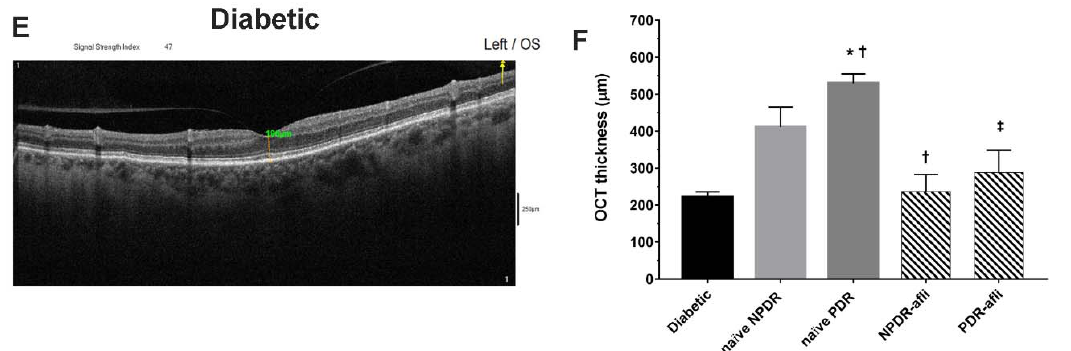
Figure 1. Representative optical coherence tomography (OCT) images of macular thickness. Aflibercept treatment decreased significantly ( p < 0.05) foveal macular thickness in non-proliferative diabetic retinopathy (NPDR) and proliferative diabetic retinopathy (PDR) patients, compared to untreated naïve groups. Foveal macular thickness measurement in enrolled subjects beloging to the followig groups: NPDR before ( A ) and after ( B ) aflibercept treatment, PDR before ( C ) and after ( D ) aflibercept treatment, and OCT evaluation in diabetic patients without DR ( E ). Mean foveal macular thickness ( F ) µ m ± S.D.; * p < 0.05 vs. diabetic; † p < 0.05 vs. NPDR naïve; ‡ vs. PDR naïve patients.